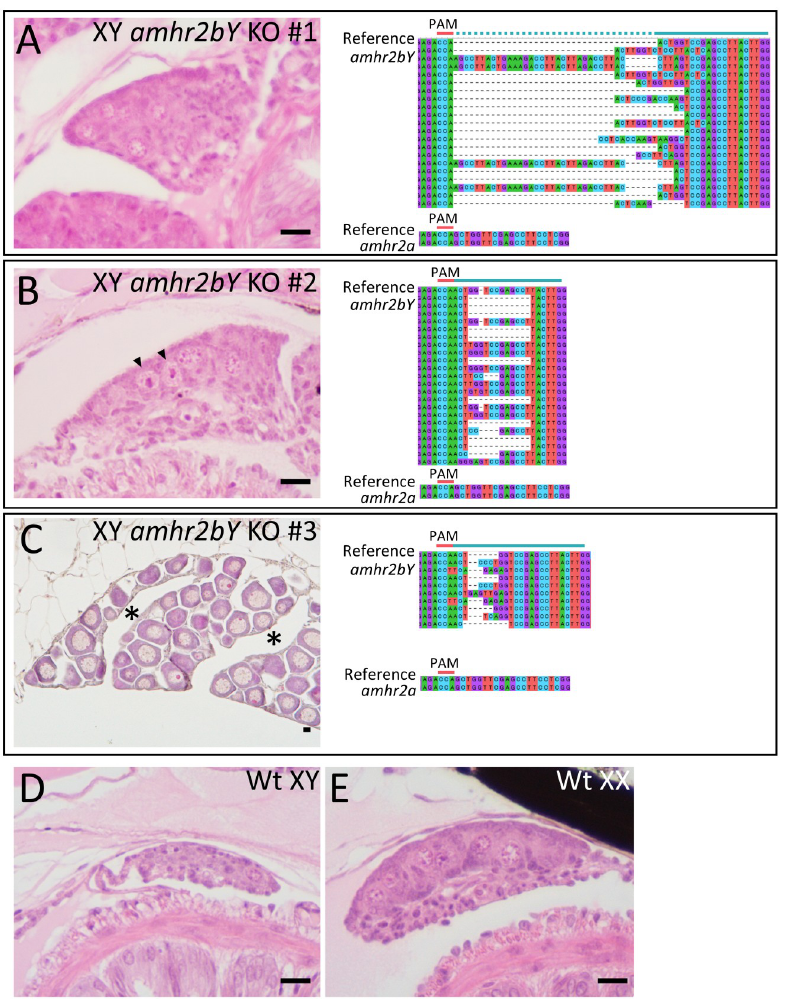
Fig 8. Loss of function analysis for amhr2bY of ayu in G0 generation using CRISPR/Cas9 system. (A and B) The gonad of amhr2bY- knockout positive XY individuals at 3 mpf. (C) The gonad of amhr2bY -knockout positive XY individuals at 6 mpf. The gonad of amhr2bY -knockout positive XY ayu individuals were differentiated to female gonad. Tissue sections were stained with hematoxylin–eosin. (A) -5 bp to +32 bp insertion / deletion were detected in XY individual #1, leading to a frame shift. (B) -11 bp to +1 bp insertion / deletion were detected in XY individual #2, leading to a frame shift. (C) +1 bp, +3 bp, +4 bp, +6 bp and -3 bp insertion / deletion were detected in XY individual #3, leading to a frame shift. Targeted sequences are highlighted in the green line. PAM sequence is in red. Off-target mutations in amhr2a was not detected. Gonad of amhr2bY- knockout negative individuals in XY (D) and XX (E). Number of germ cells in XX gonads were larger than XY. Arrowheads in B indicate germ cells during mitosis. Asterisk in C indicates ovarian cavity. Scale bar: 10 μ m.